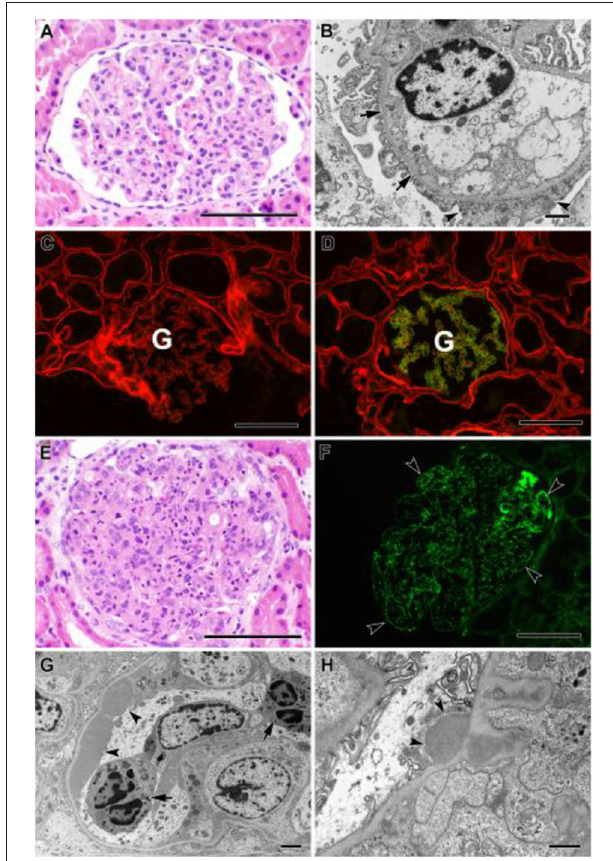
FIGURE 2 | (A–D) Biopsy findings in patient YB. (A) Glomerulus from paraffin section showing minimal histologic abnormality (hematoxylin and eosin stain). Bar = 100 µ m. (B) Electron micrograph showing mild, patchy podocyte foot process effacement (arrowheads), and mild thinning of capillary loop basement membrane without thickening or lamellation (arrows). No immune complex deposits were identified. Bar = 1 µ m. (C,D) Two-color immunofluorescent stains of fresh frozen tissue for α 2 (red) and α 5 (green) chains of type IV collagen. (C) Patient’s biopsy, showing total loss of staining for α 5 chain in the glomerulus (G) , consistent with Alport syndrome. (D) Positive control tissue showing normal pattern of staining for α 5 chain confined to capillaries in the glomerulus (G) , with more diffuse staining for α 2 chain. Bars = 100 µ m. (E–H) Biopsy findings in patient OB. (E) Glomerulus from paraffin section, showing global hypercellularity with abundant infiltration of neutrophils (hematoxylin and eosin stain). Bar = 100 µ m. (F) Immunofluorescent stain of fresh frozen biopsy tissue for IgG showing extensive granular staining of capillary loops (arrowheads). Bar = 100 µ m. (G) Electron micrograph showing large subendothelial immune complex deposit (arrowheads) and neutrophils within capillary lumen (arrows). Bar = 2 µ m. (H) Electron micrograph showing subepithelial immune complex deposit (“hump,” arrowheads). Bar =